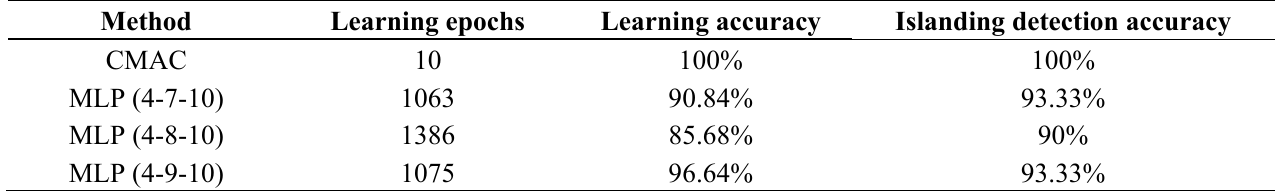
Table 8. Accuracy comparison between CMAC and MLP neural network methods.